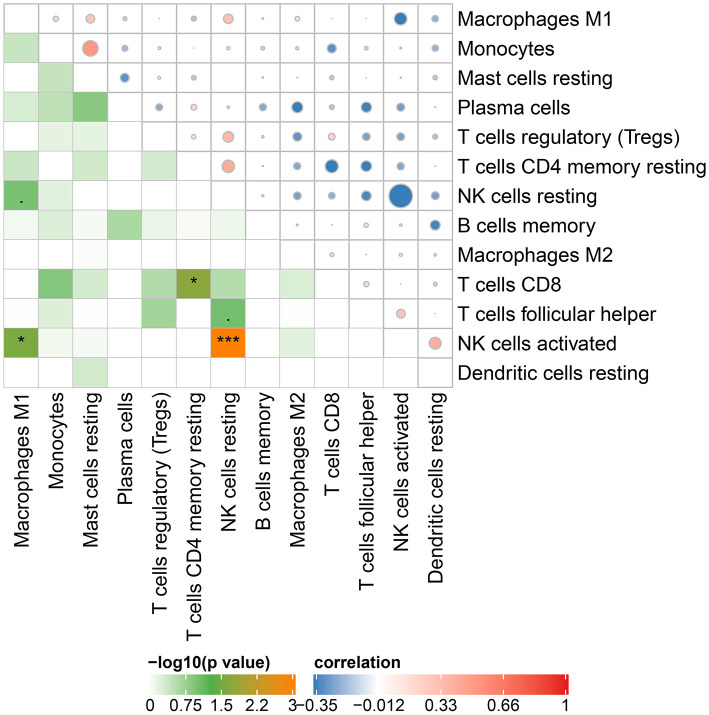
Correlation matrix of 13 immune cell subtype compositions. Blue dots represent negative correlation, and red dots represent positive correlation. The size of the dot is positively correlated with the correlation coefficient. *p < 0.05 and ***p < 0.001.